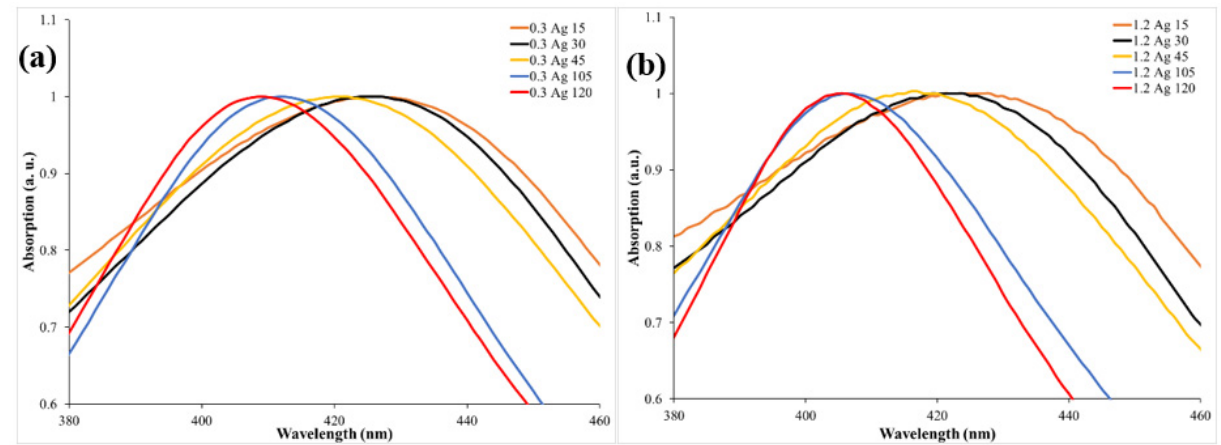
Figure 5. UV–vis absorption spectra of Ag NPs using two concentrations of Origanum majorana extract solution: ( a ) 0.3 mL and ( b ) 1.2 mL at different irradiation times. Table 1. SPR position and irradiation time for two concentrations of Origanum majorana extract solution: 0.3 mL and 1.2 mL. Item Sample time